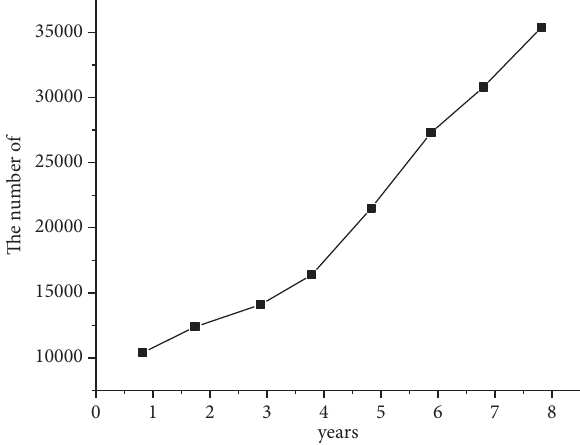
Figure 1: Changes of online shopper